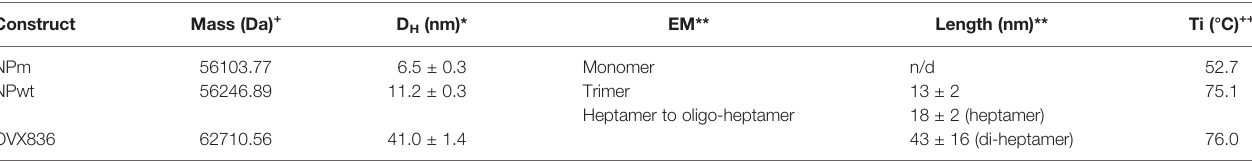
TABLE 1 | Structural characteristics of the NP proteins.